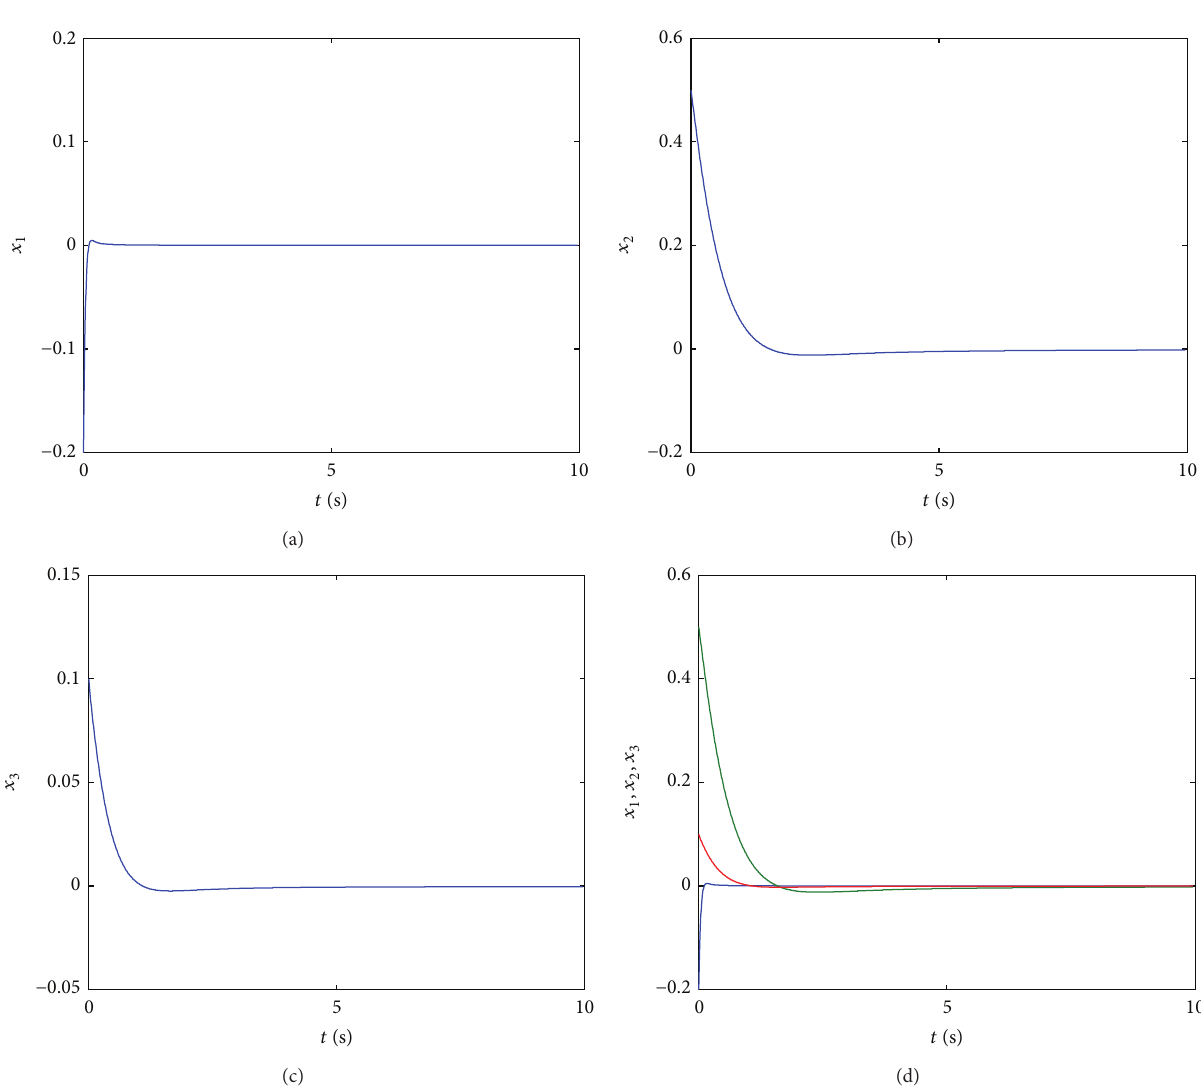
Figure 6: Time waveforms of state variables 𝑥 1 (𝑎) , 𝑥 2 (𝑏) , and 𝑥 3 (𝑐) of the controlled fractional order L¨u system.